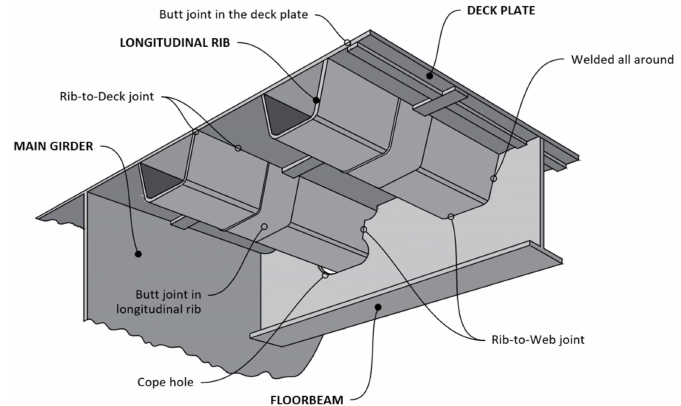
Figure 1. Components of an orthotropic slab deck (re-adapted from